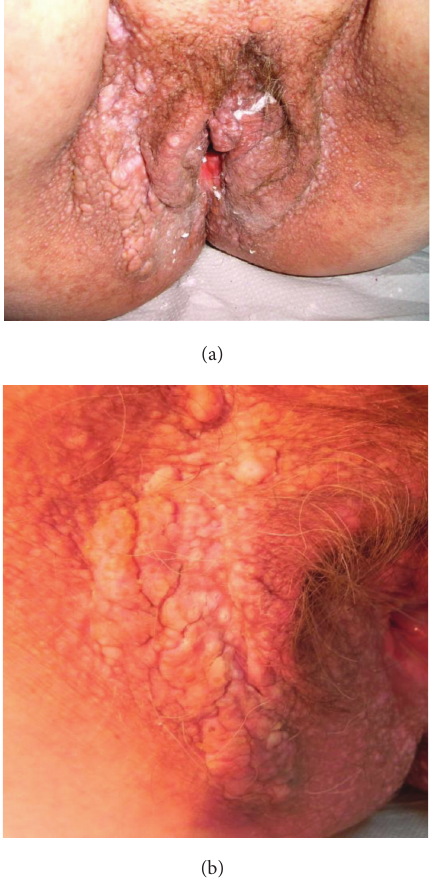
Figure 7: Papules also include the perineum and vulvae region. show variable consistency; similarly, this patient also had identical clinical features.